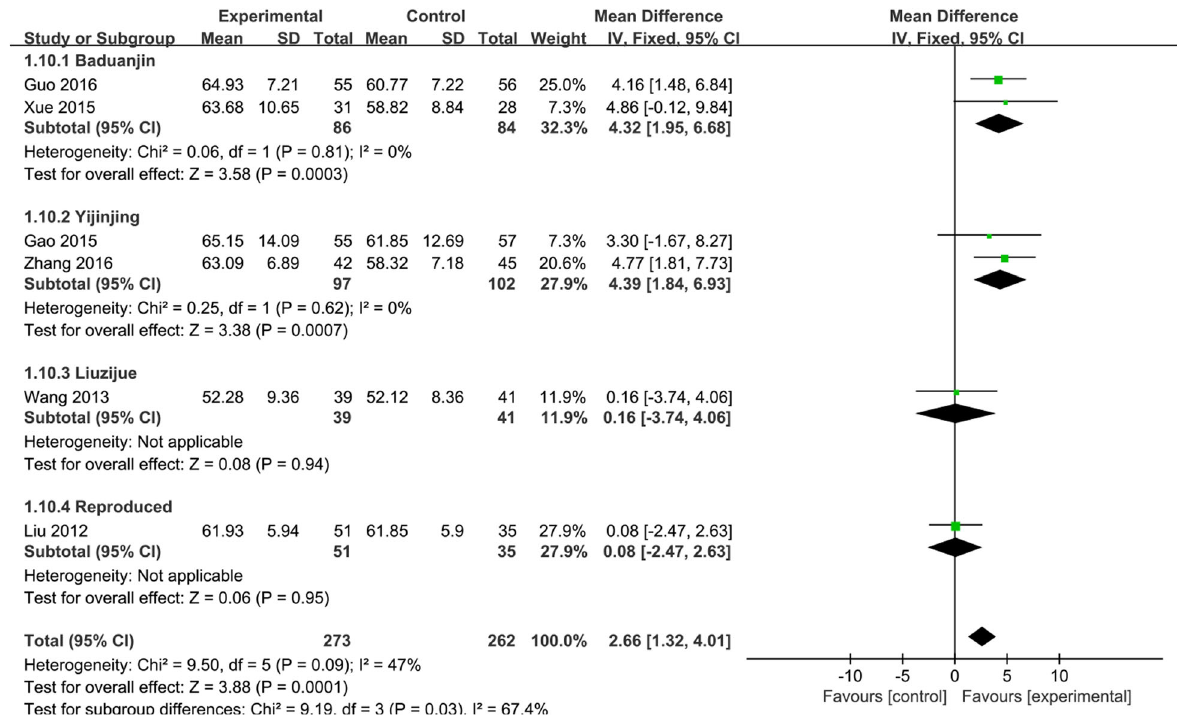
Fig. 4 Effects of Qigong on the forced vital capacity rate of 1 s/forced vital capacity (FEV1/FVC). Subgroup meta-analysis was used to assess the effects of different types of Qigong on the FEV1/FVC with a fixed effects